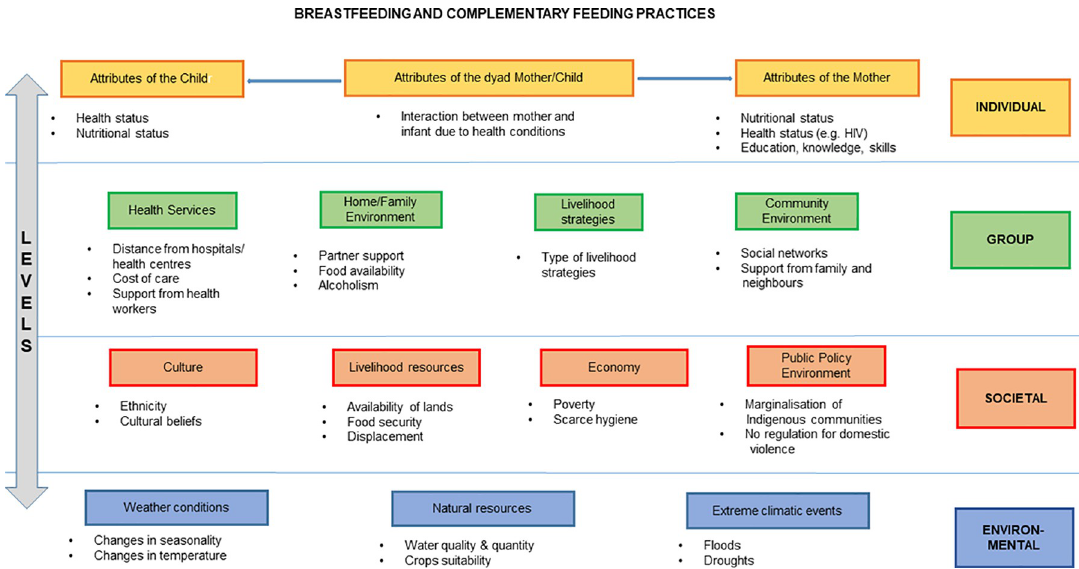
Fig 1. Conceptual framework used to analyse breastfeeding and complementary feeding among the Batwa and Bakiga communities. The group level refers to the level of household and community; the societal level refers to the level of region, ethnicities and country. There is interaction across all levels; for example, the environmental level interacts with the societal and group